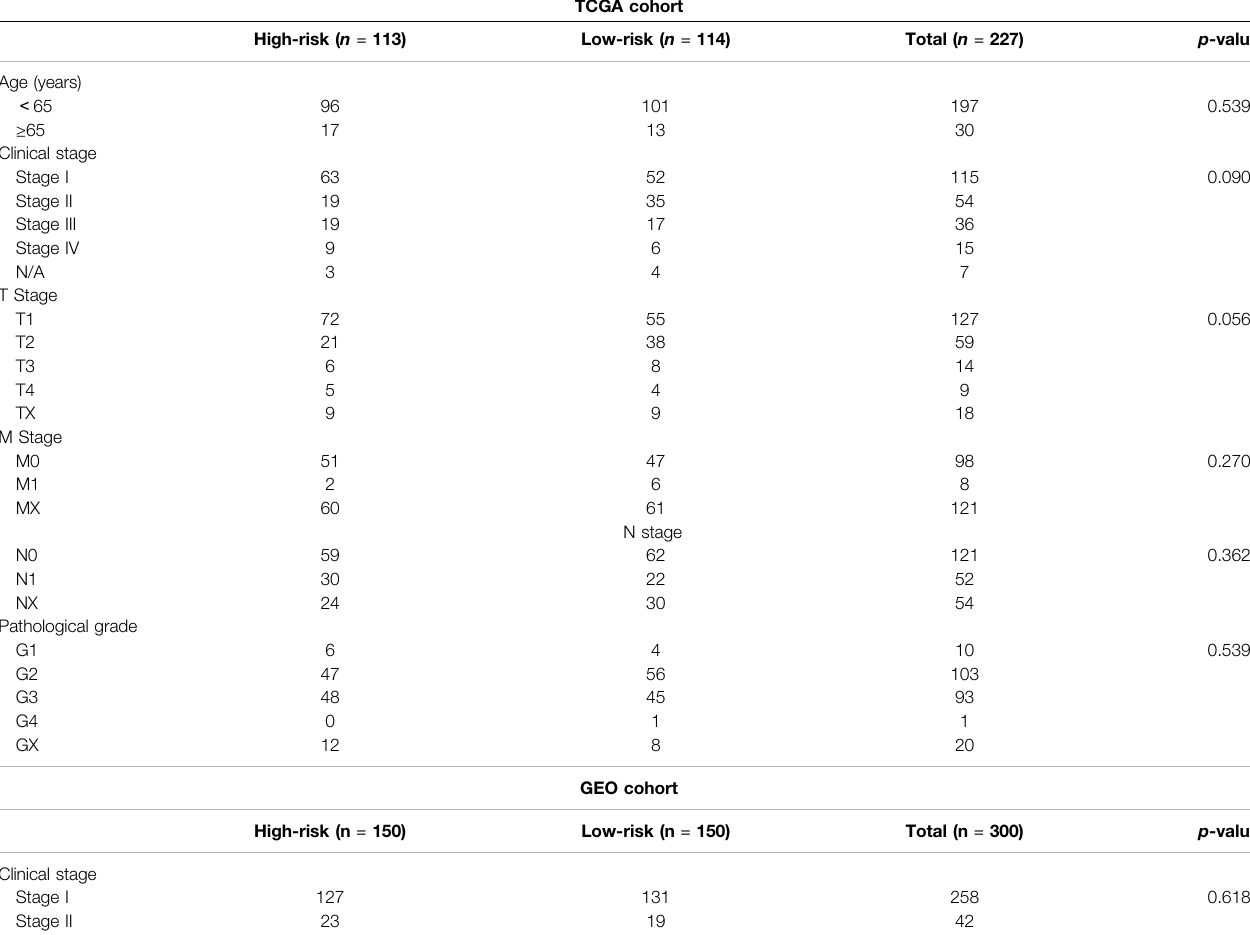
TABLE 1 | Clinical characteristics of TCGA and GEO